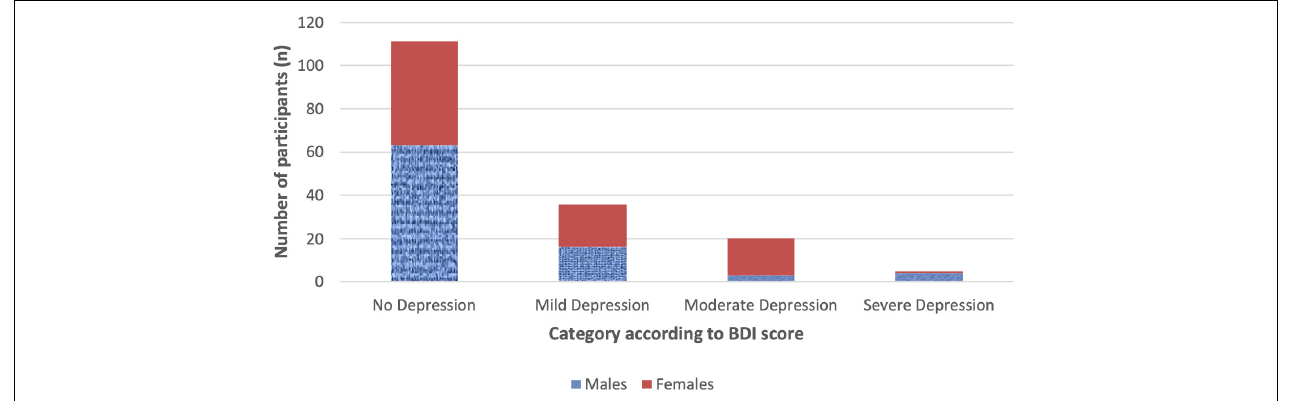
FIGURE 1 | BDI scoring by gender.